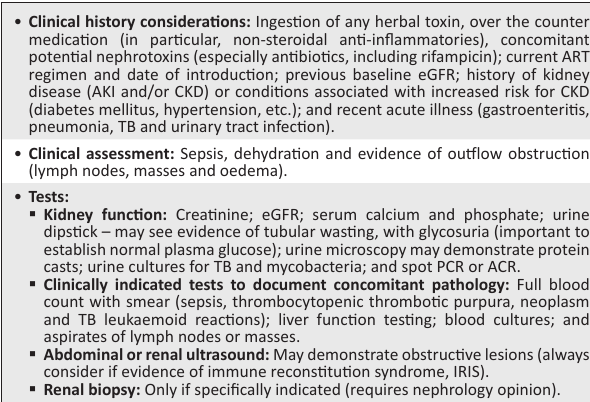
BOX 1: Rapid clinical approach for an HIV patient with kidney dysfunction taking antiretrovirals. • Clinical history considerations: Ingestion of any herbal toxin, over the counter medication (in particular, non-steroidal anti-inflammatories), concomitant potential nephrotoxins (especially antibiotics, including rifampicin); current ART regimen and date of introduction; previous baseline eGFR; history of kidney disease (AKI and/or CKD) or conditions associated with increased risk for CKD (diabetes mellitus, hypertension, etc.); and recent acute illness (gastroenteritis, pneumonia, TB and urinary tract infection).